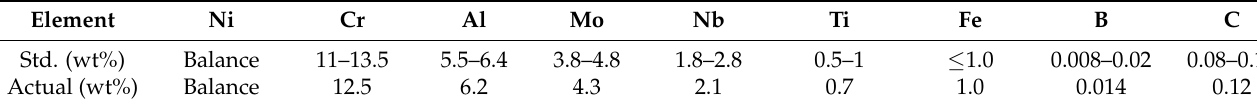
Table 1. Element composition of K418 Superalloy.